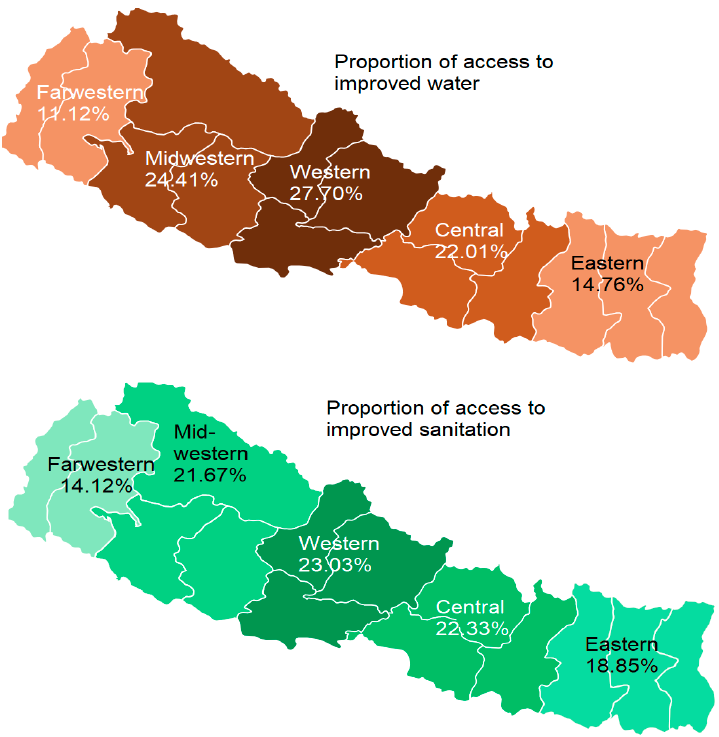
Figure 8. Over regional differences in improved sanitation and water access in 2016.